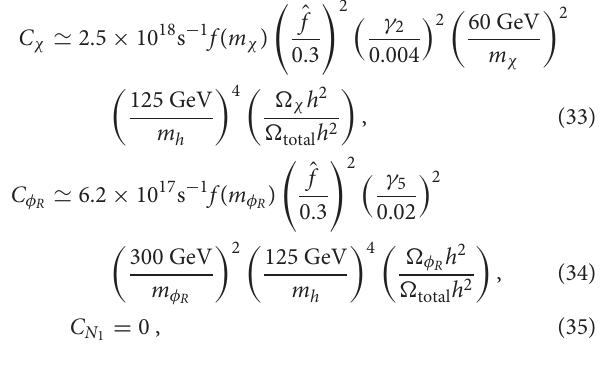
500 GeV and γ 7 =